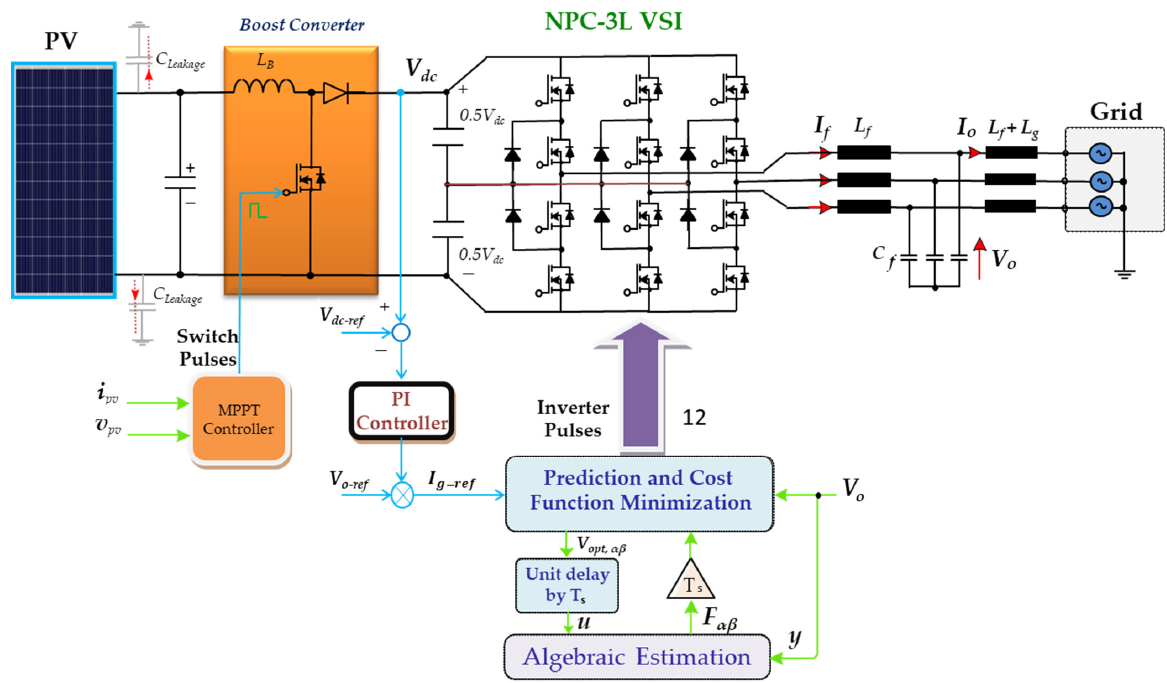
Figure 1. Proposed PV-powered NPC transformerless inverter with the MFPC.